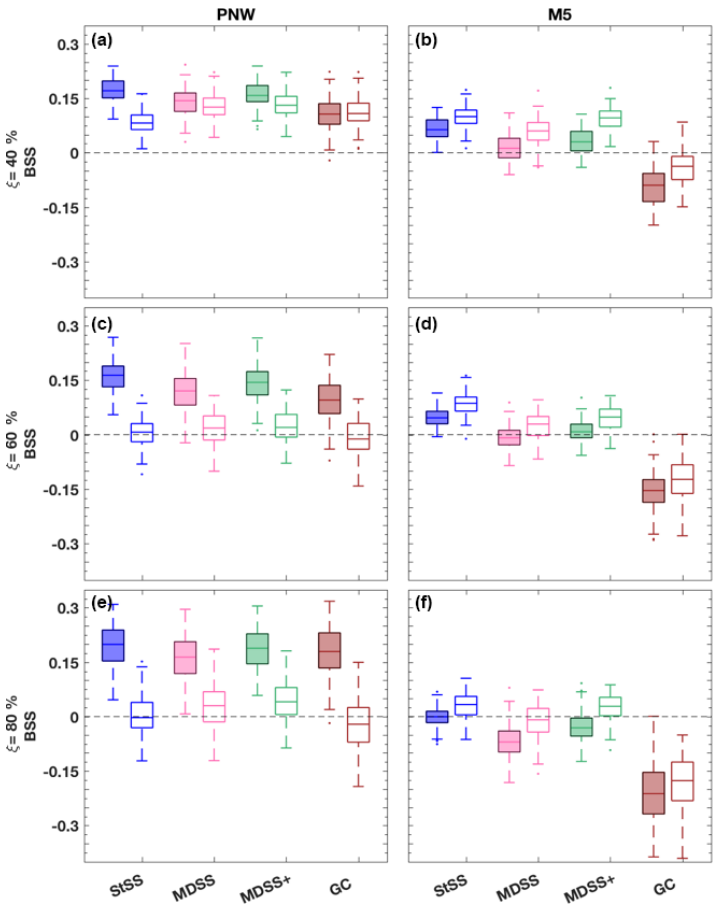
Figure 11. Box plots of BSS of power ramp events identified in 6h time windows from forecast scenarios generated with the StSS (blue), MDSS (pink), MDSS + (green), and GC (brown) methods. BSSs are shown for the PNW tower location ( a , c , and e ) and the M5 tower location ( b , d , f ) and for up-ramps (filled box plots) and down-ramps (non-filled box plots). Ramp events with a power threshold of ξ = 40% ( a and b ), 60% ( c and d ), and 80% ( e and f ) change in the turbine power capacity are shown. The box plots display the interquartile range (rectangle region), the median (middle line within rectangle), outliers (dots), and values outside the interquartile range but not considered outliers (lower and upper whisker) of the distributions. Outliers are values more than 1.5 times the interquartile range. For reference, a line (gray dashed) showing zero skill is